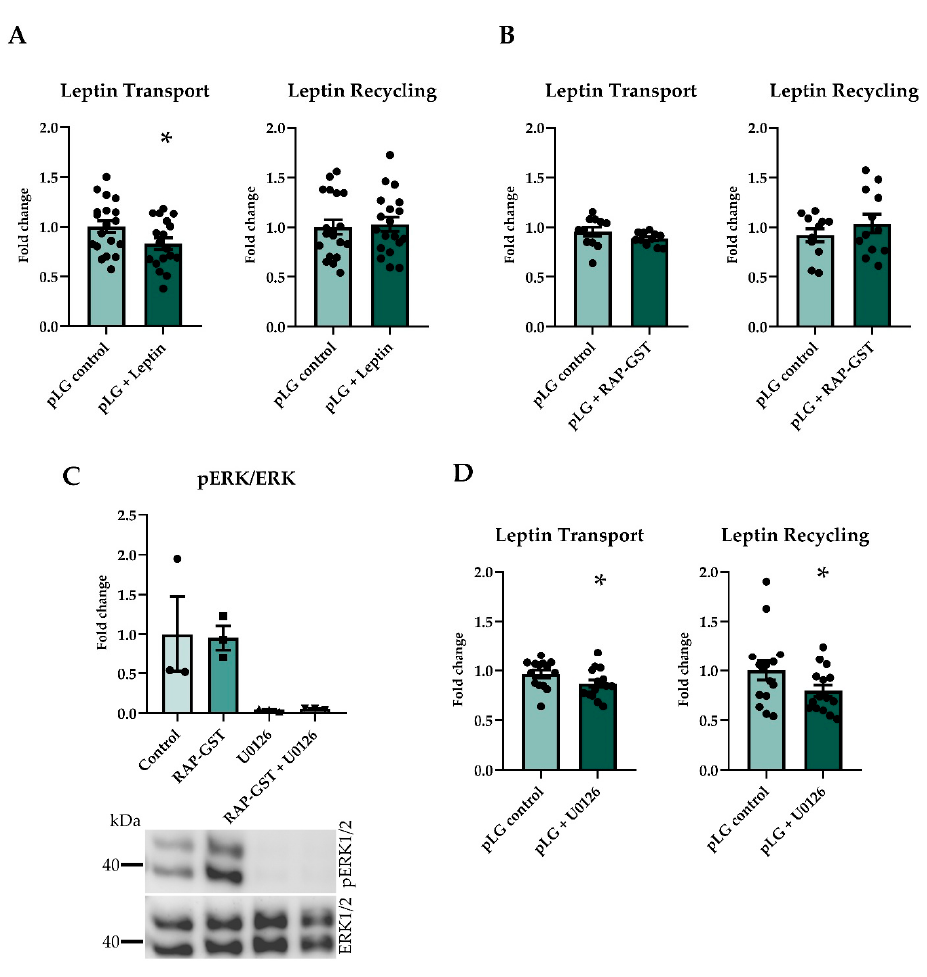
Figure 2. Pulse chase assays using different inhibitors and co-treatments. Pretreatment and co-treatment with recombinant porcine leptin reduced transport but not recycling ( A ) ( n = 18–19). RAP-GST, an LRP antagonist, did not inhibit the transport or recycling of leptin ( B ) ( n = 11–12). U0126 abolished the phosphorylation of ERK1/2, also when co-treated with RAP-GST, and RAP-GST did not influence the phosphorylation of ERK1/2 ( C ) ( n = 3). Inhibiting the phosphorylation of ERK using U0126 significantly reduced transport and recycling of leptin ( D ) ( n = 14–15). Results are presented as mean ± SEM * p < 0.05.